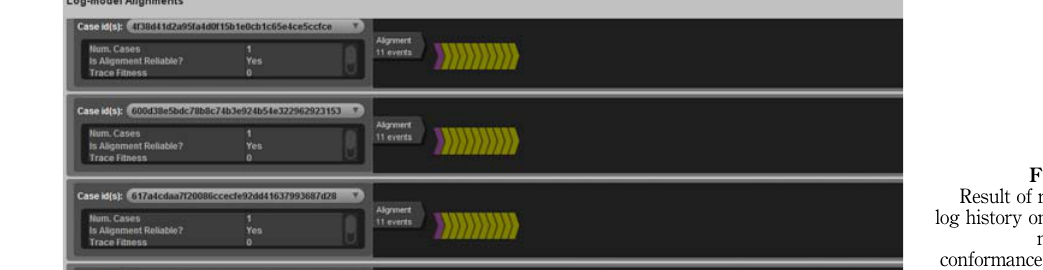
Figure 3. Result of replaying